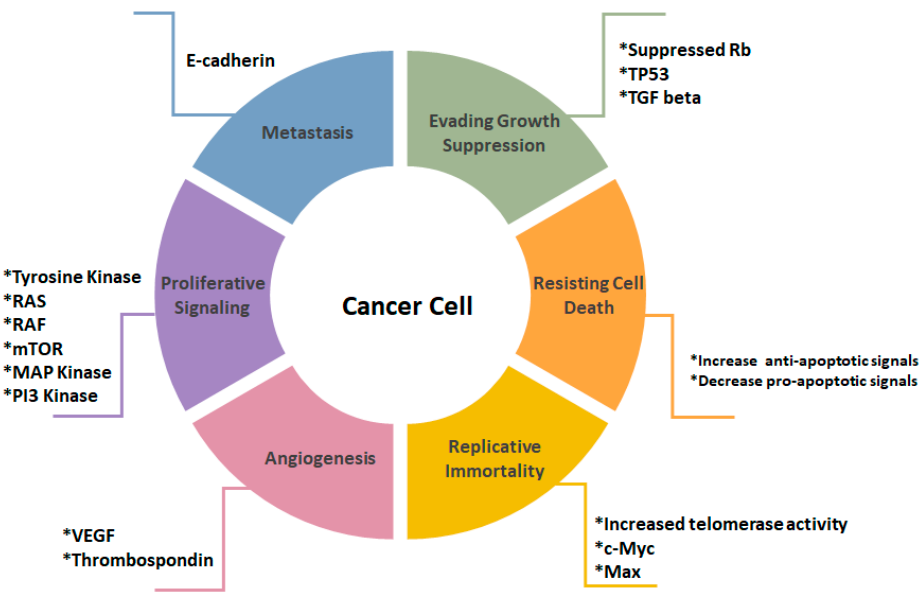
Figure 1. Illustration of cancer cell hallmarks. Evasion of growth suppression is mediated by inhibition of Rb, TP 53 and TGF beta. Resistance in cell death is signified by increase in anti-apoptotic and a decrease in pro-apoptotic factors. Replicative immortality is result of an increase in telomerase activity, c-Myc and Max. Angiogenesis is promoted due to the increase in VEGF and thrombospondin. The increased proliferative signaling is emphasized by increased tyrosine kinase activity, Ras, Raf, m-TOR, MAP kinase and PI3-kinase. Metastasis formation is marked by the loss of E-cadherin [4].